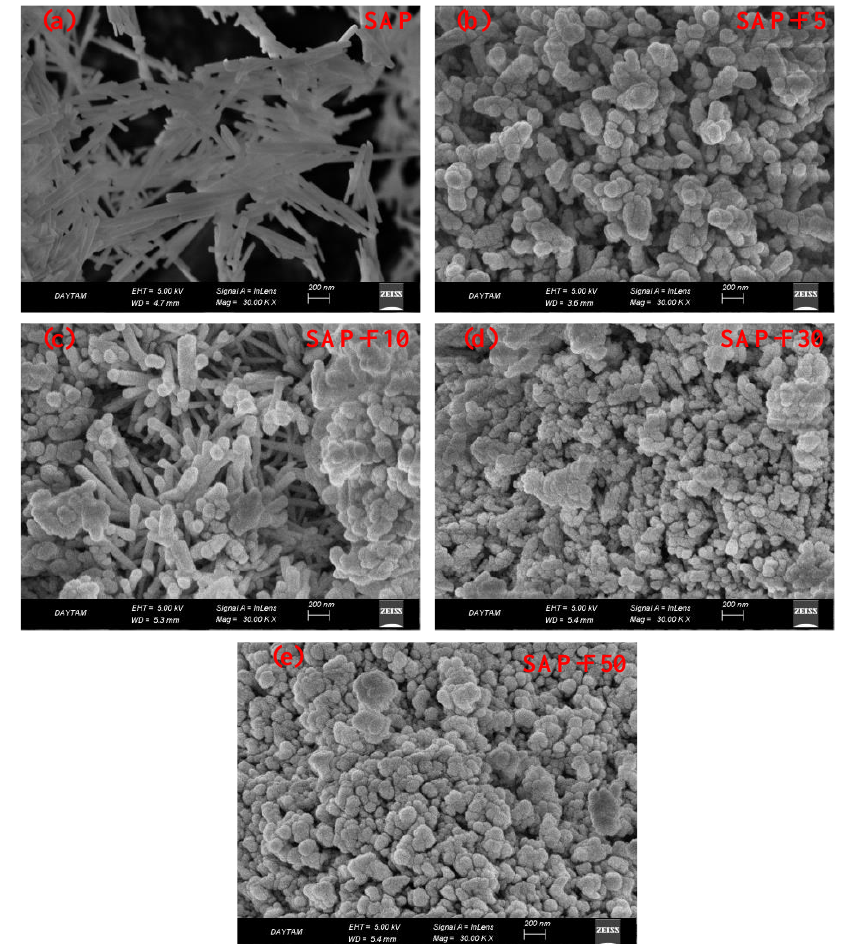
Figure 4. FE-SEM images of synthesized nanoparticles.